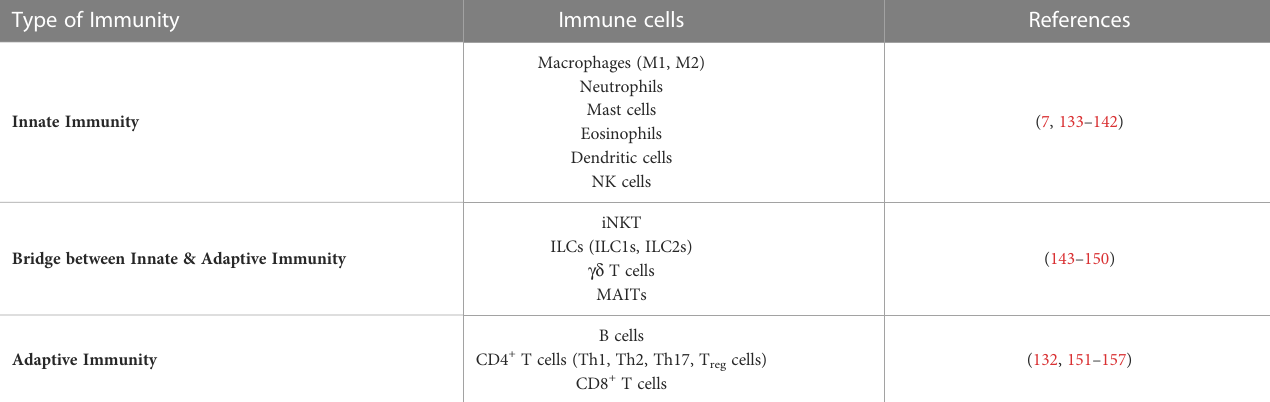
TABLE 1 Immune cells (innate, adaptive and bridging innate & adaptive immunity) found in adipose tissues. Type of